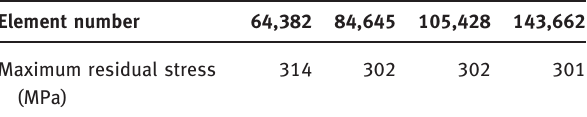
Table 2: Sensitivity of the element number on the maximum residual stress. Element number